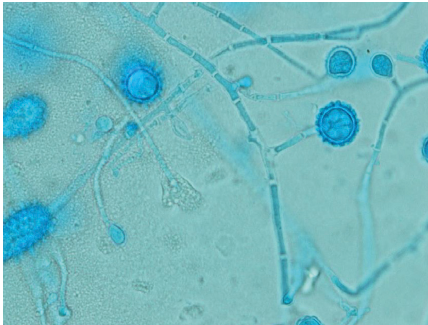
Figure 2: Tape preparation slide of Histoplasma capsulatum from left upper lobe tissue culture viewed at 100x